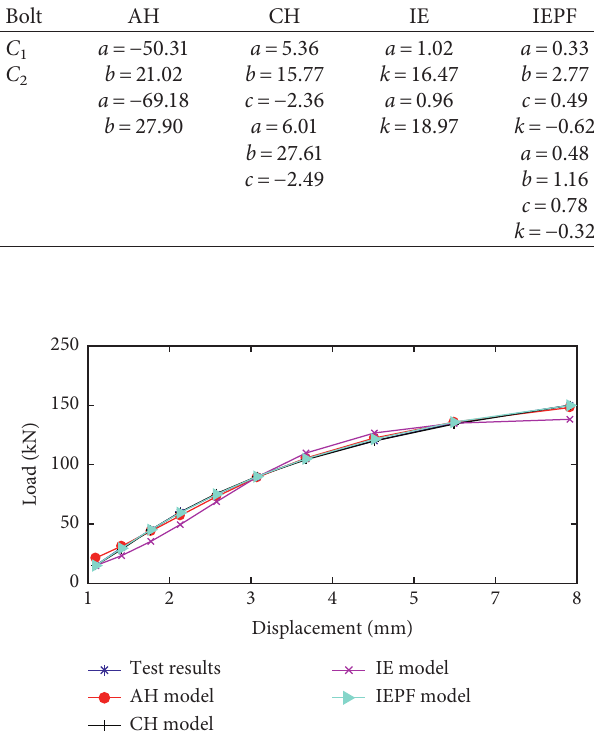
Figure 7: Comparison of each model with the test data from C